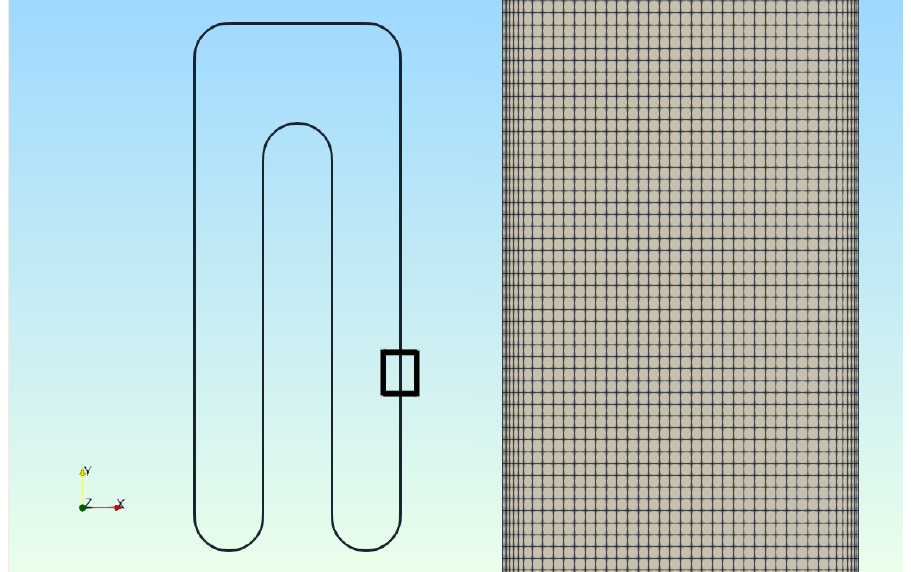
Figure 3. Generated